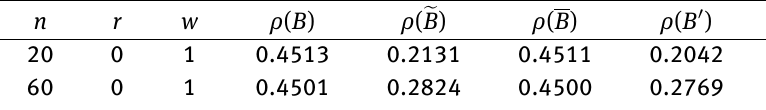
Table 3: Comparison of spectral radius of Jacobi